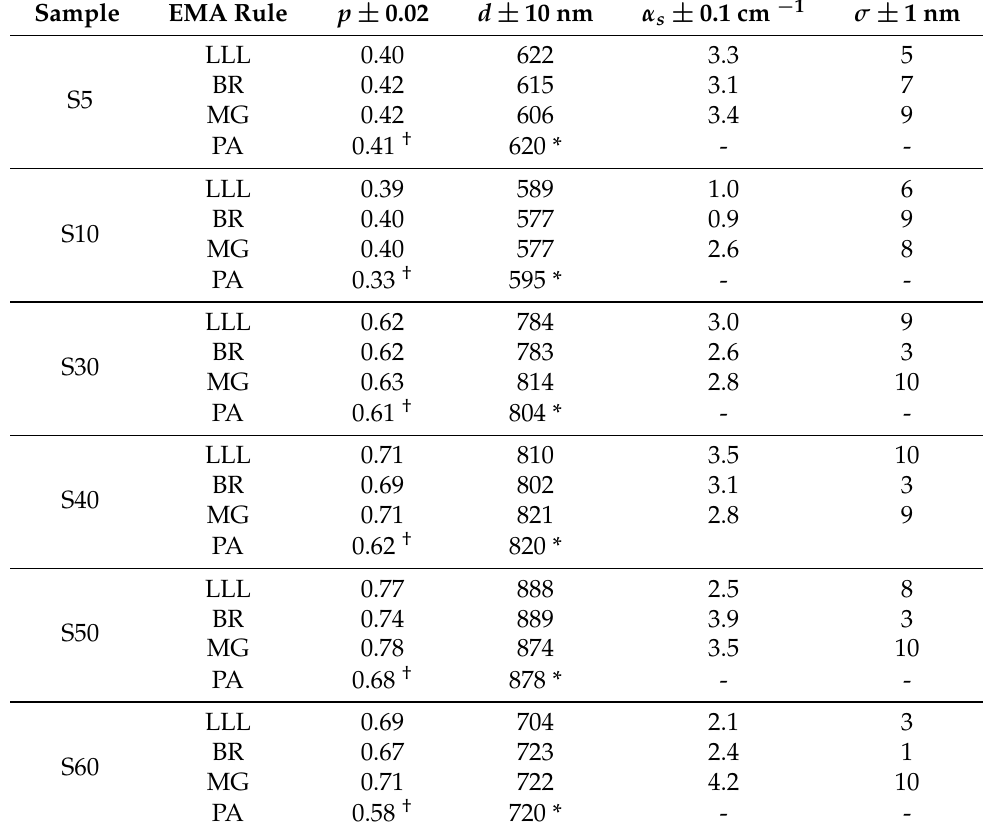
Table 2. Experimentally observed and numerically optimized values for the porosity ( p ) , thickness ( d ) , absorption coefficient ( α s ) , and roughness ( σ ) using effective media approximation combined with genetic algorithms and in situ